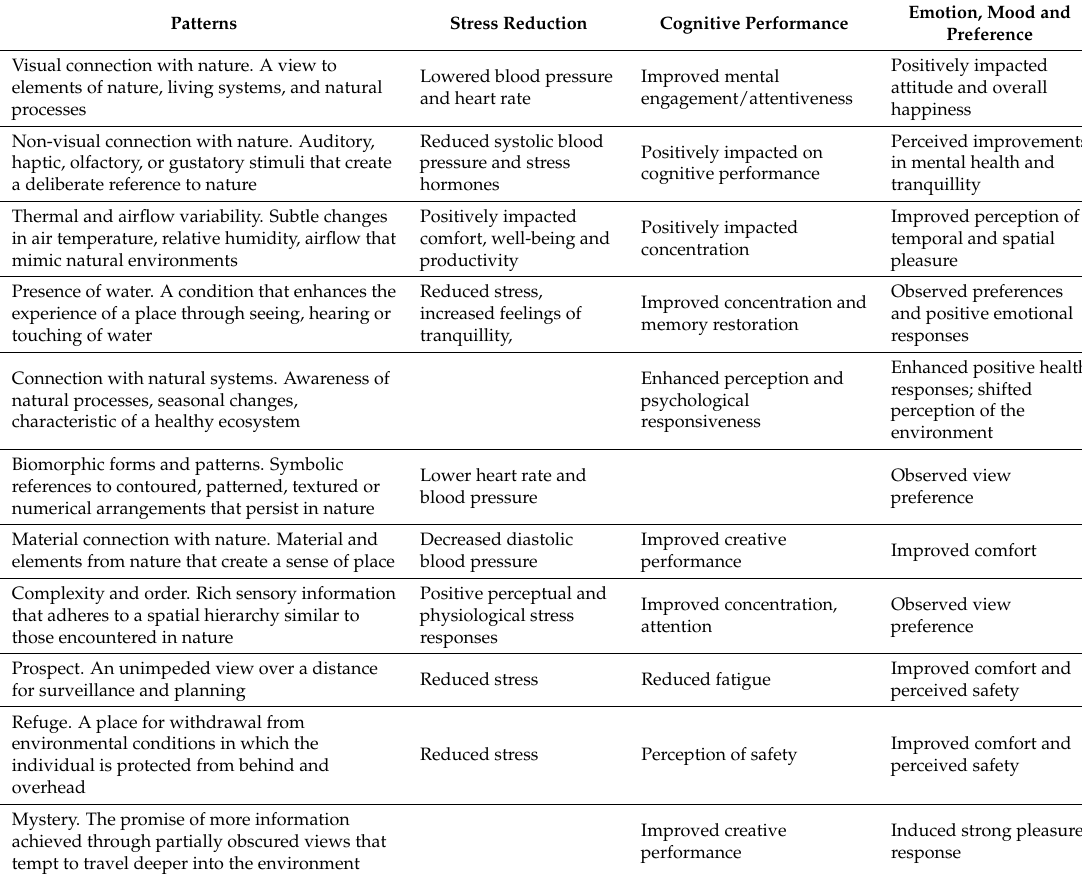
Table 2. The patterns of a biophilic design and their functions in supporting stress reduction, cognitive performance, emotion, mood and preference (adapted from Reference